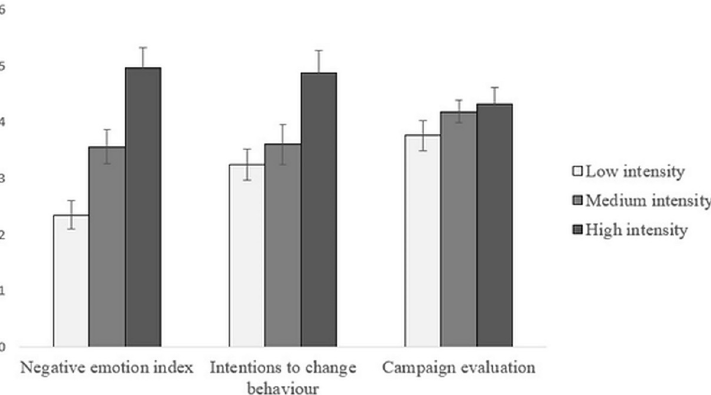
Fig 4. Negative emotions felt by participants, intention to change behavior, and campaign evaluation as a function of the intensity of negative emotions in the social campaign. Error bars represent ± 1 standard errors.